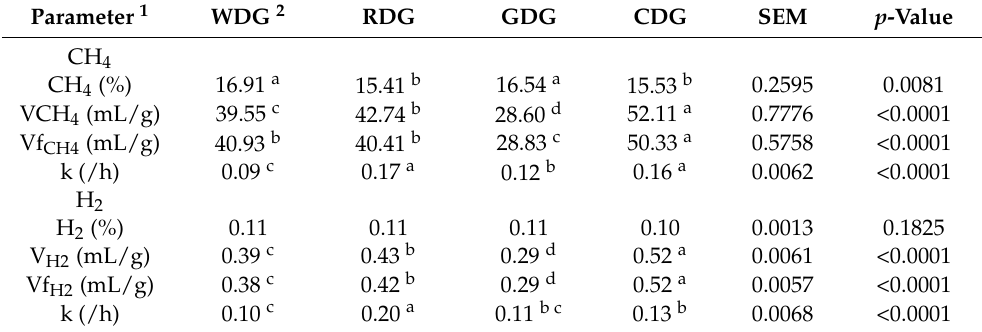
Table 3. Methane and hydrogen production of four types of distiller’s grains.